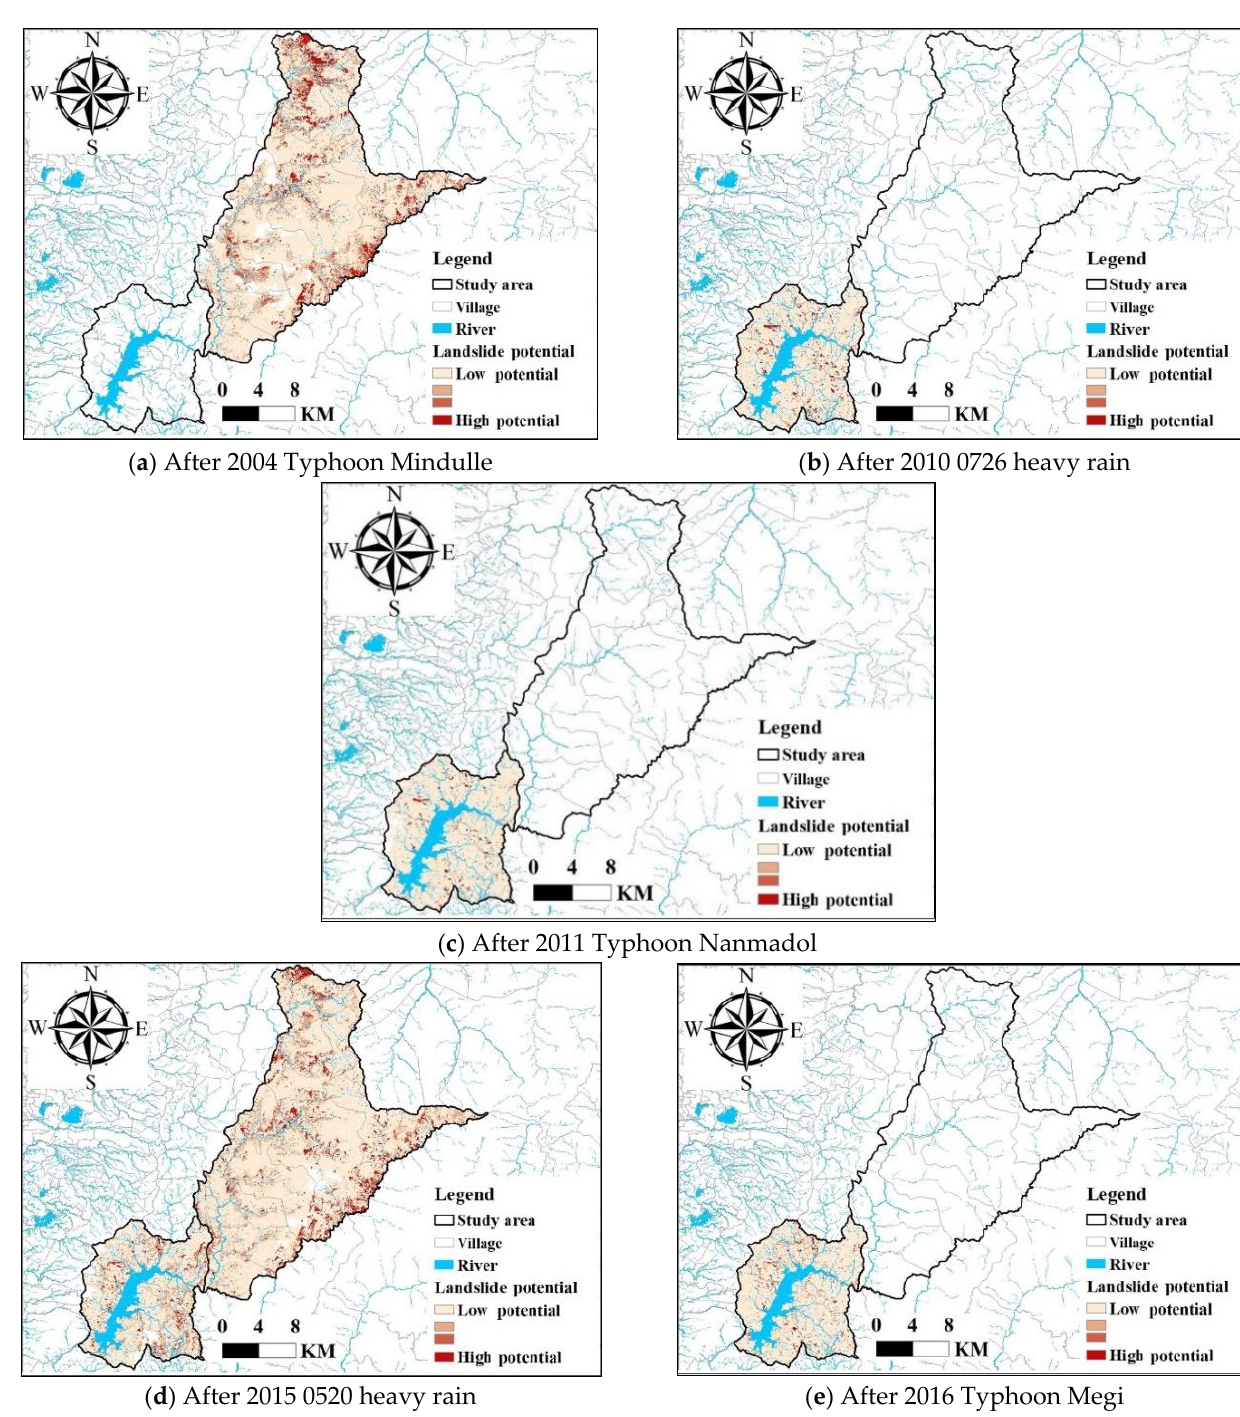
Figure 6. Single rainfall event-induced landslide potential.